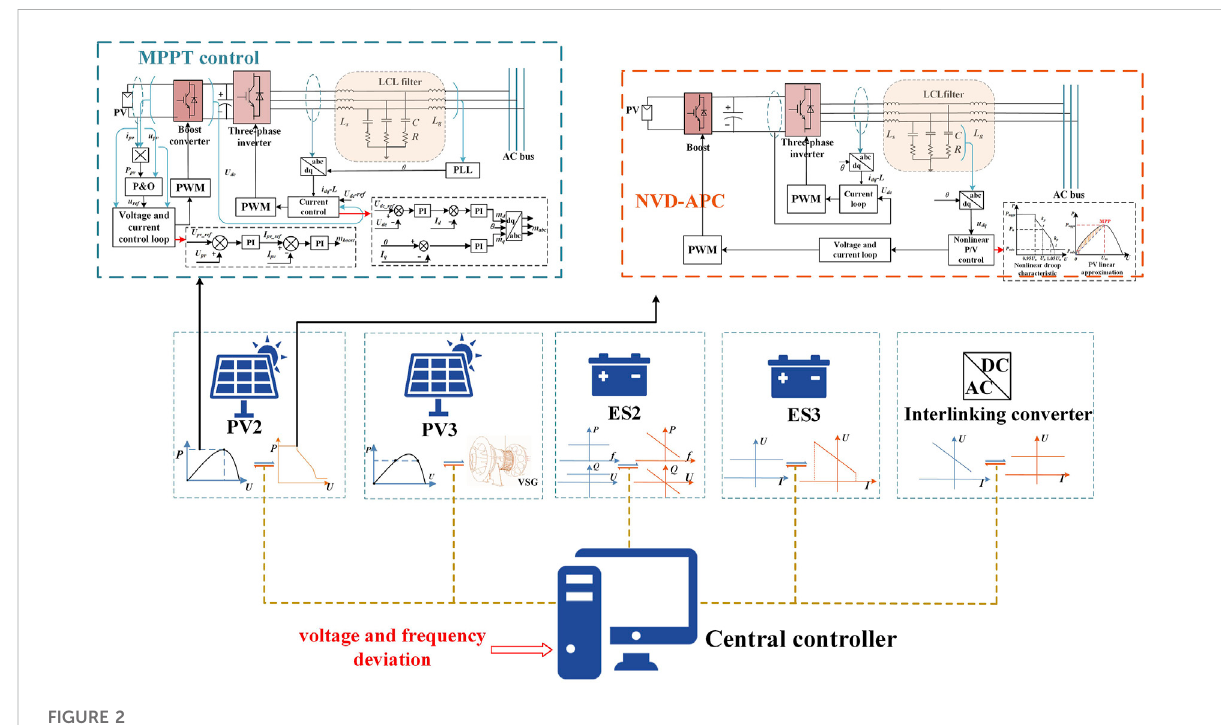
FIGURE 2 The control diagram of PV2.